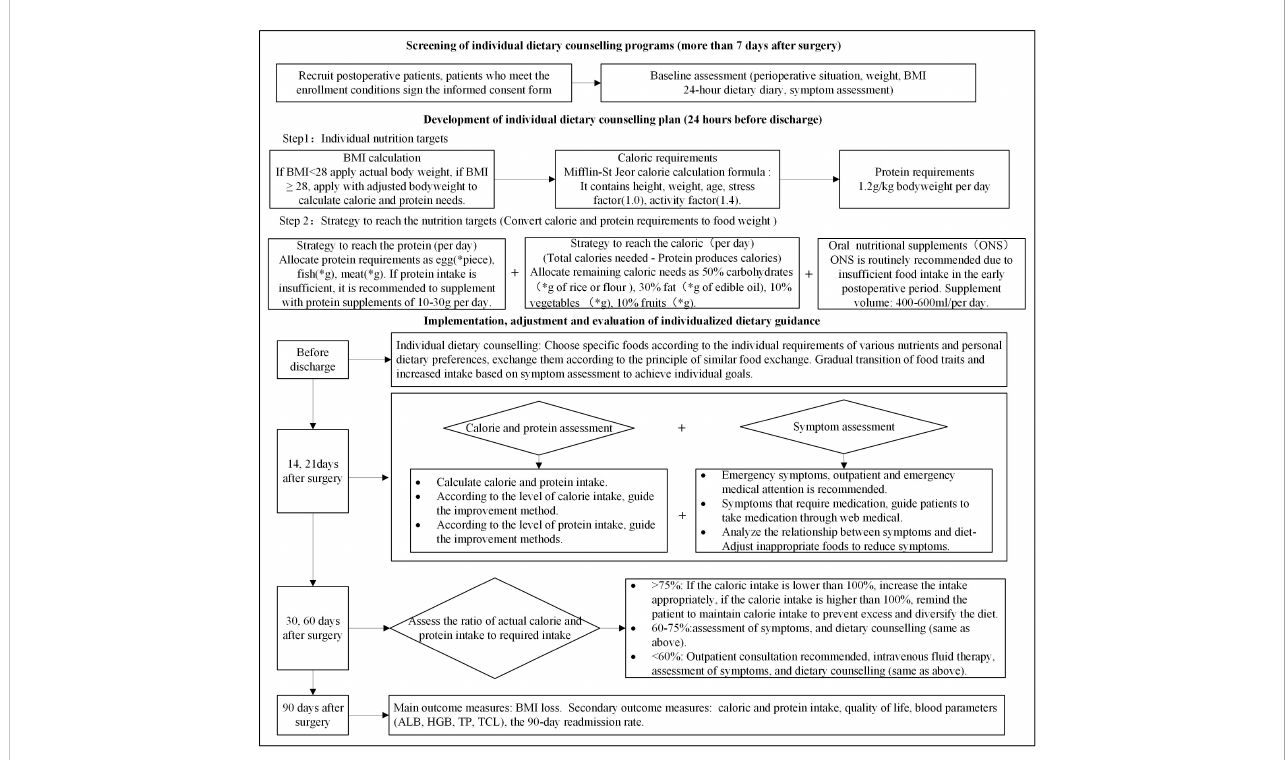
FIGURE 1 Intervention group study fl ow chart. Twenty-four – hour diet diary (self-designed form); symptom assessment (MDASI-C); “ * ” , calculate according to the patient ’ s